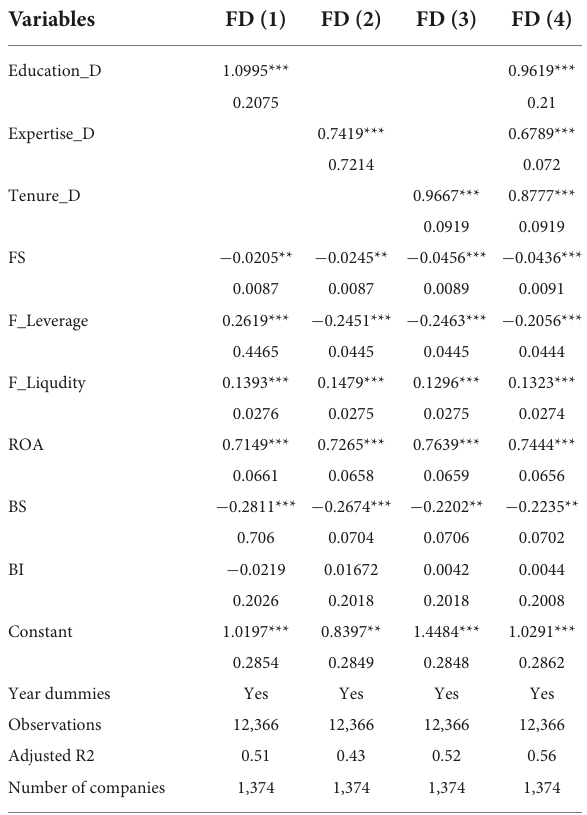
TABLE 5 Fixed effect regression